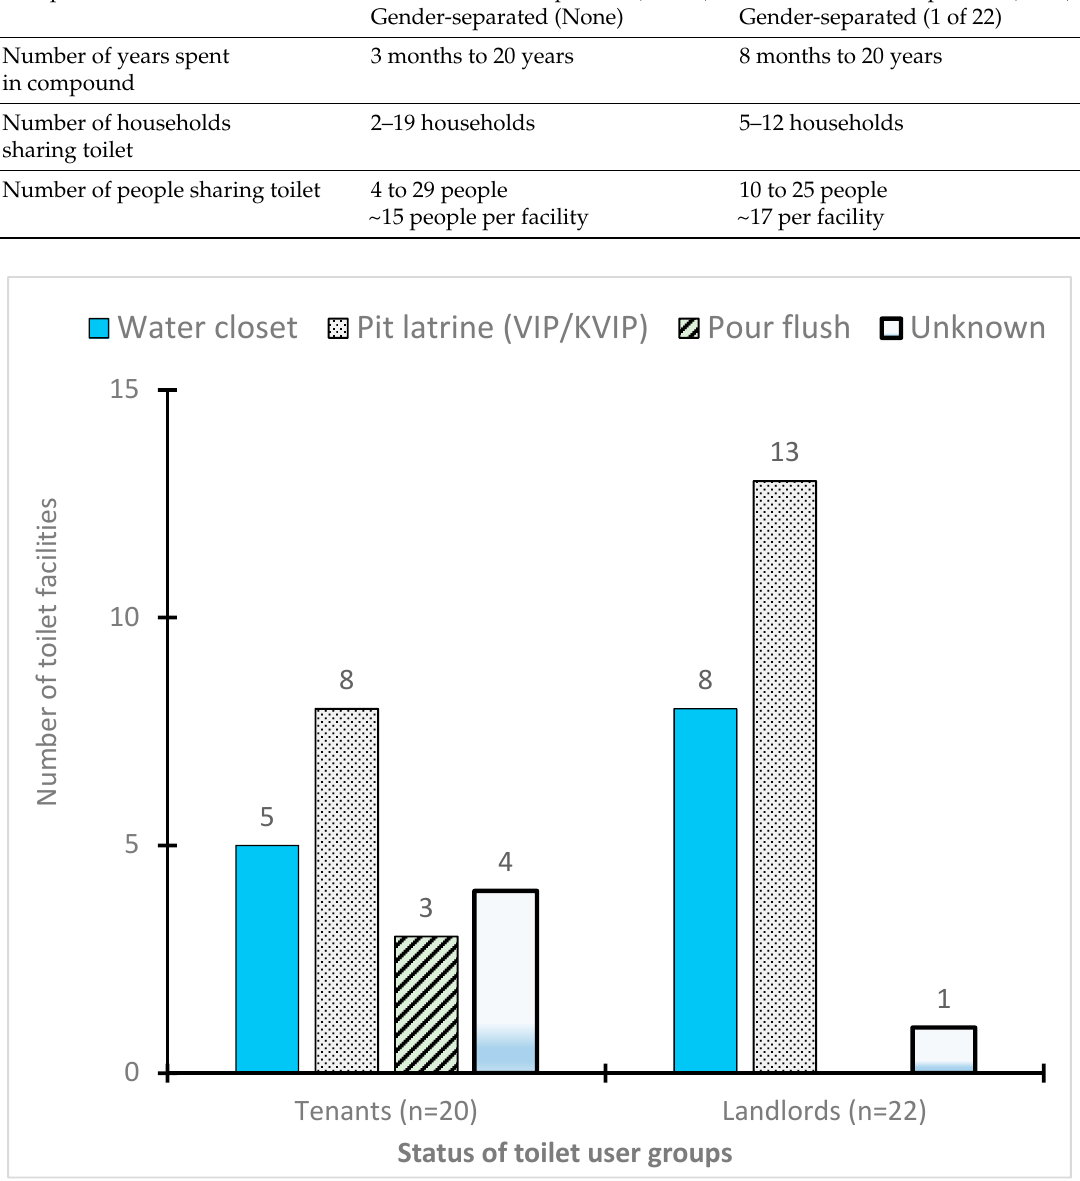
Figure 1. Types of shared sanitation facilities used by participants of the in-depth interviews (IDI). KVIP—Kumasi ventilated improved pit latrine, VIP—ventilated improved pit latrine.